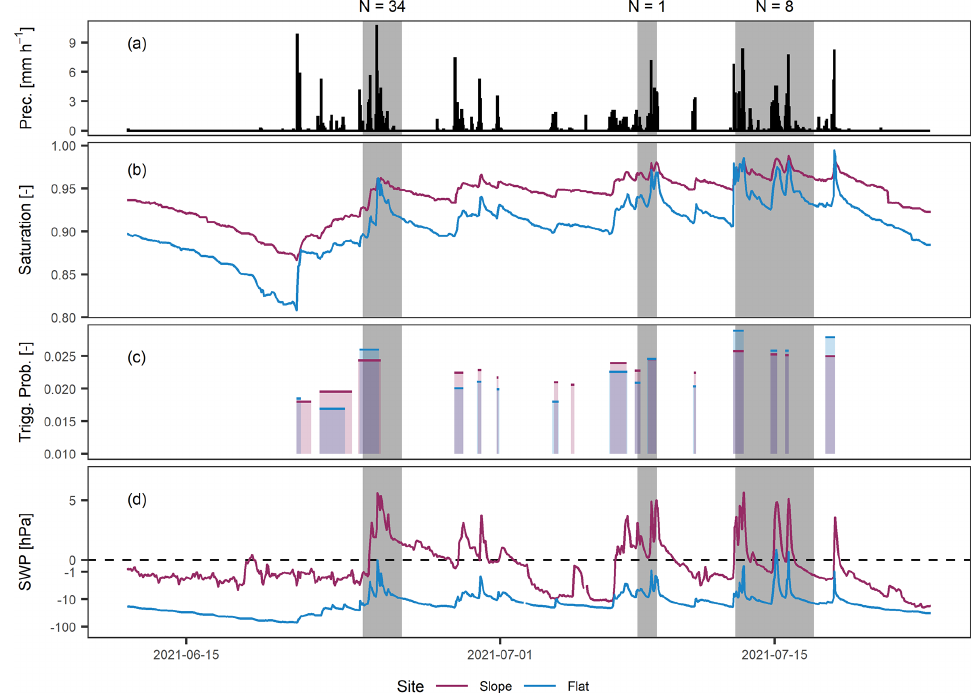
Figure 8. Time series extract for a period of 40d in summer 2021 showing hourly precipitation sums at the sloped site (a) , as well as the profile mean saturation (b) , the triggering probabilities of the statistical landslide prediction model (c) , and the profile mean SWP (d) at the two sites. The grey bars indicate consecutive days with observed landslides and the numbers ( N ) indicate the number of landslide events recorded within a distance of